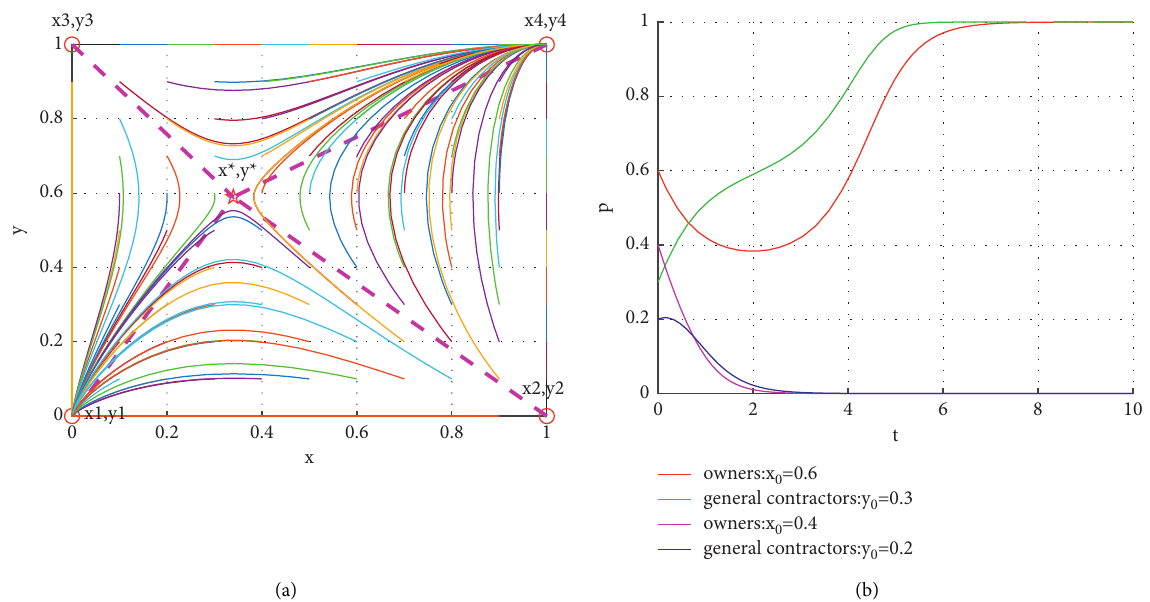
Figure 1: Dynamic evolution in Scenario 6. (a) Evolution path. (b) Evolution with different initial